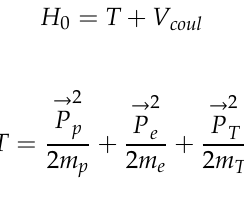
Figure 1. The relative position vectors of the particles involved in 3-body collisions. → → → → → r T − r p and C = r p − r e , in such way that